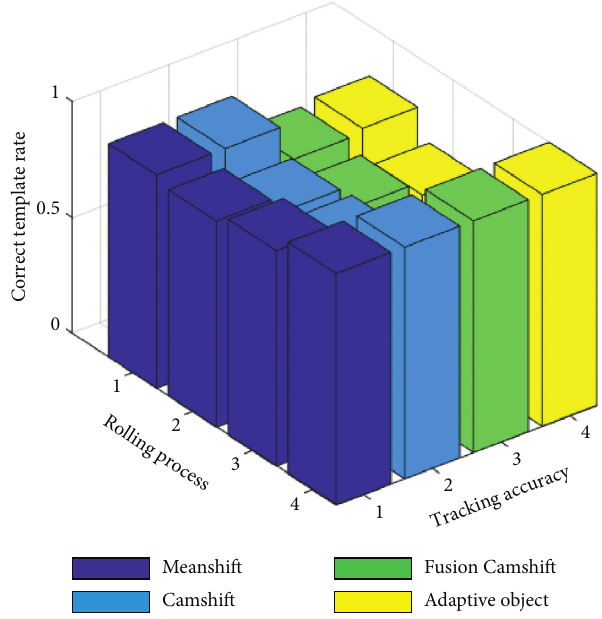
Figure 5: Correct template rate of different algorithms.